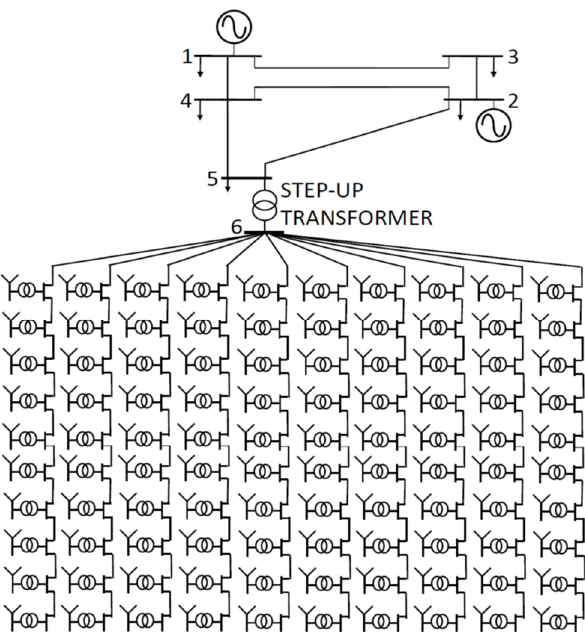
Figure 6. Test system. Table 3. Test system line data (in pu).